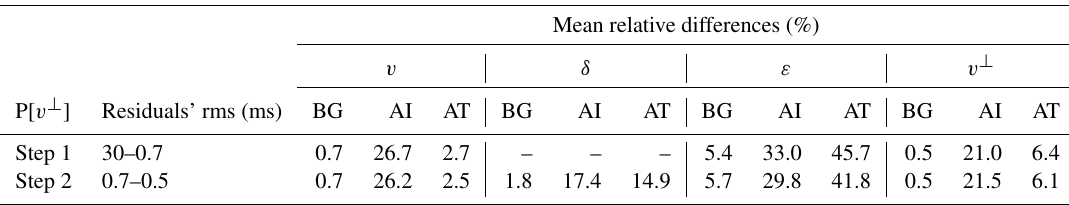
Figure 10. Same as Fig. 9 but using target models as initial models for all parameters in P[ v ⊥ ] except for δ . The magnitude of the δ anomaly is better recovered than for P[ ε ], but the shape is not as well retrieved, and artifacts appear in the background area. Differences between inverted and target v and v ⊥ models are still hardly observable but not as much as for v and ε in the case of P[ ε ], and thus the recovery of ε through Eq. (2) is also not as good. Table 6. Same as Table 5 but for the two-step sequential inversion of P[ v ⊥ ] (Fig. 8). Model fits are similar to those achieved by the simultaneous inversion of this parameterization: v and v ⊥ are well retrieved, while recovery of δ and ε is unsuccessful. Final data fit is identical to the one obtained by simultaneously inverting for P[ v ⊥